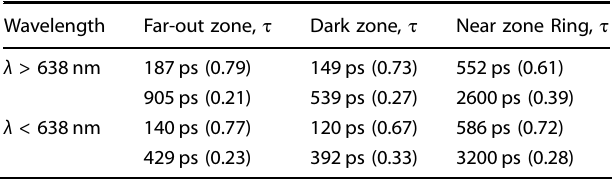
Fig. 3 Time-resolved photoluminescence from FIB-milled ML WS 2 . a Experimental setup of the time-resolved fl uorescence confocal microscope; b PL mapping of a FIB-milled sample, with a scale bar of 10 µm; c PL intensity pro fi le at positions along the dashed line in b as a function of lateral position, less than (blue) and greater than (pink) 638 nm; d the time-resolved decay curves at three locations for wavelengths less than and greater than 638 nm: in the far-out zone (yellow squares), in the dark zone (red triangles), and on the “ ring ” (green circles). Table 1. Exponential lifetimes, τ , and pre-exponential amplitudes in parenthesis of the PL emissions at different locations, fi tted with two exponential